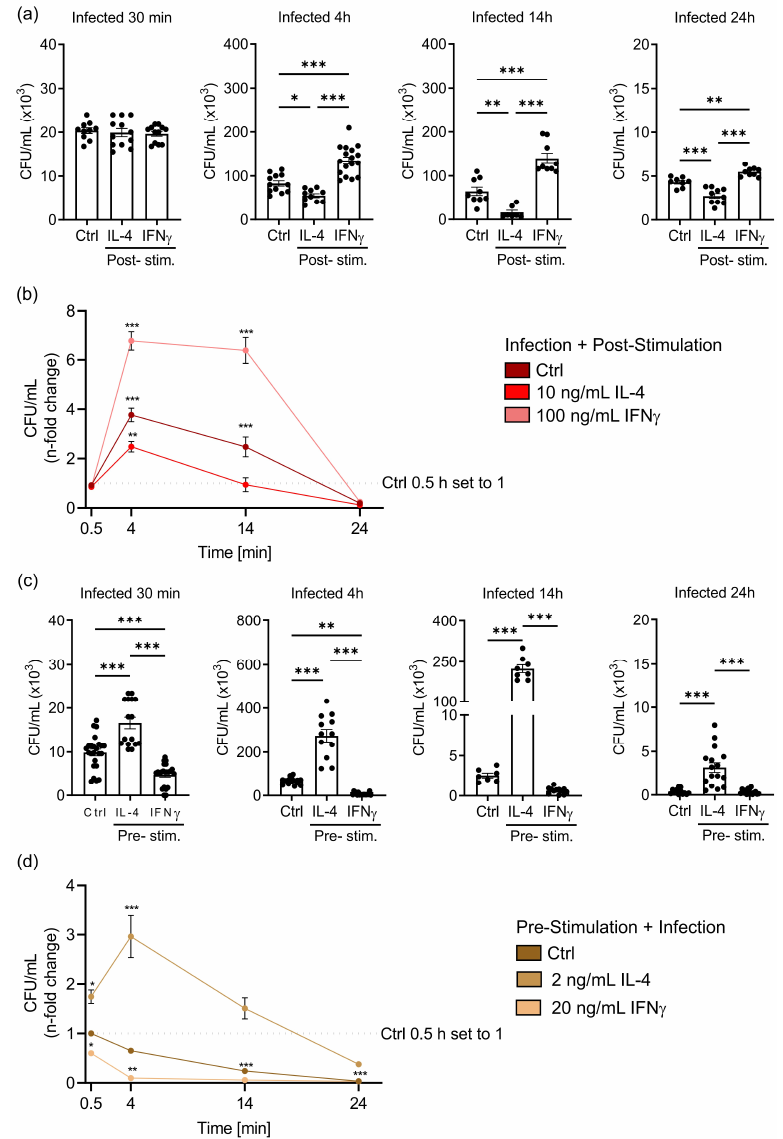
Figure 2. IL-4 stimulation of macrophages before or after infection determines the control of Salmonella infection. Unpolarised BMDM and pre-stimulated polarised BMDM (2 ng/mL IL-4 or 20 ng/mL IFN γ ) were infected with S .tm for 1 h. Unpolarised cells were then stimulated (post-stimulation) with 10 ng/mL IL-4, 100 ng/mL IFN γ as indicated or left unstimulated. Differences between colony-forming units (CFU) were analysed. ( a ) Uptake of S .tm (Infected 30 min) and quantification of intracellular CFU in post-stimulated macrophages (Infected 4 h, 14 h, and 24 h). ( b ) Normalized intracellular CFU over time in post-stimulated BMDM. ( c ) Uptake of S .tm in pre-stimulated BMDM and killing capacity over the course of 24 h. ( d ) Normalized intracellular CFU over time in pre-stimulated BMDM. Statistical significance was determined by one-way ANOVA with Tukey post hoc test (a + c) and by two-way ANOVA with Tukey post hoc tests (b + d). * p -value < 0.05; ** p -value < 0.01; *** p -value < 0.001. Representative data (mean ± SEM) from three independent experiments performed in technical triplicates or quadruplicates are